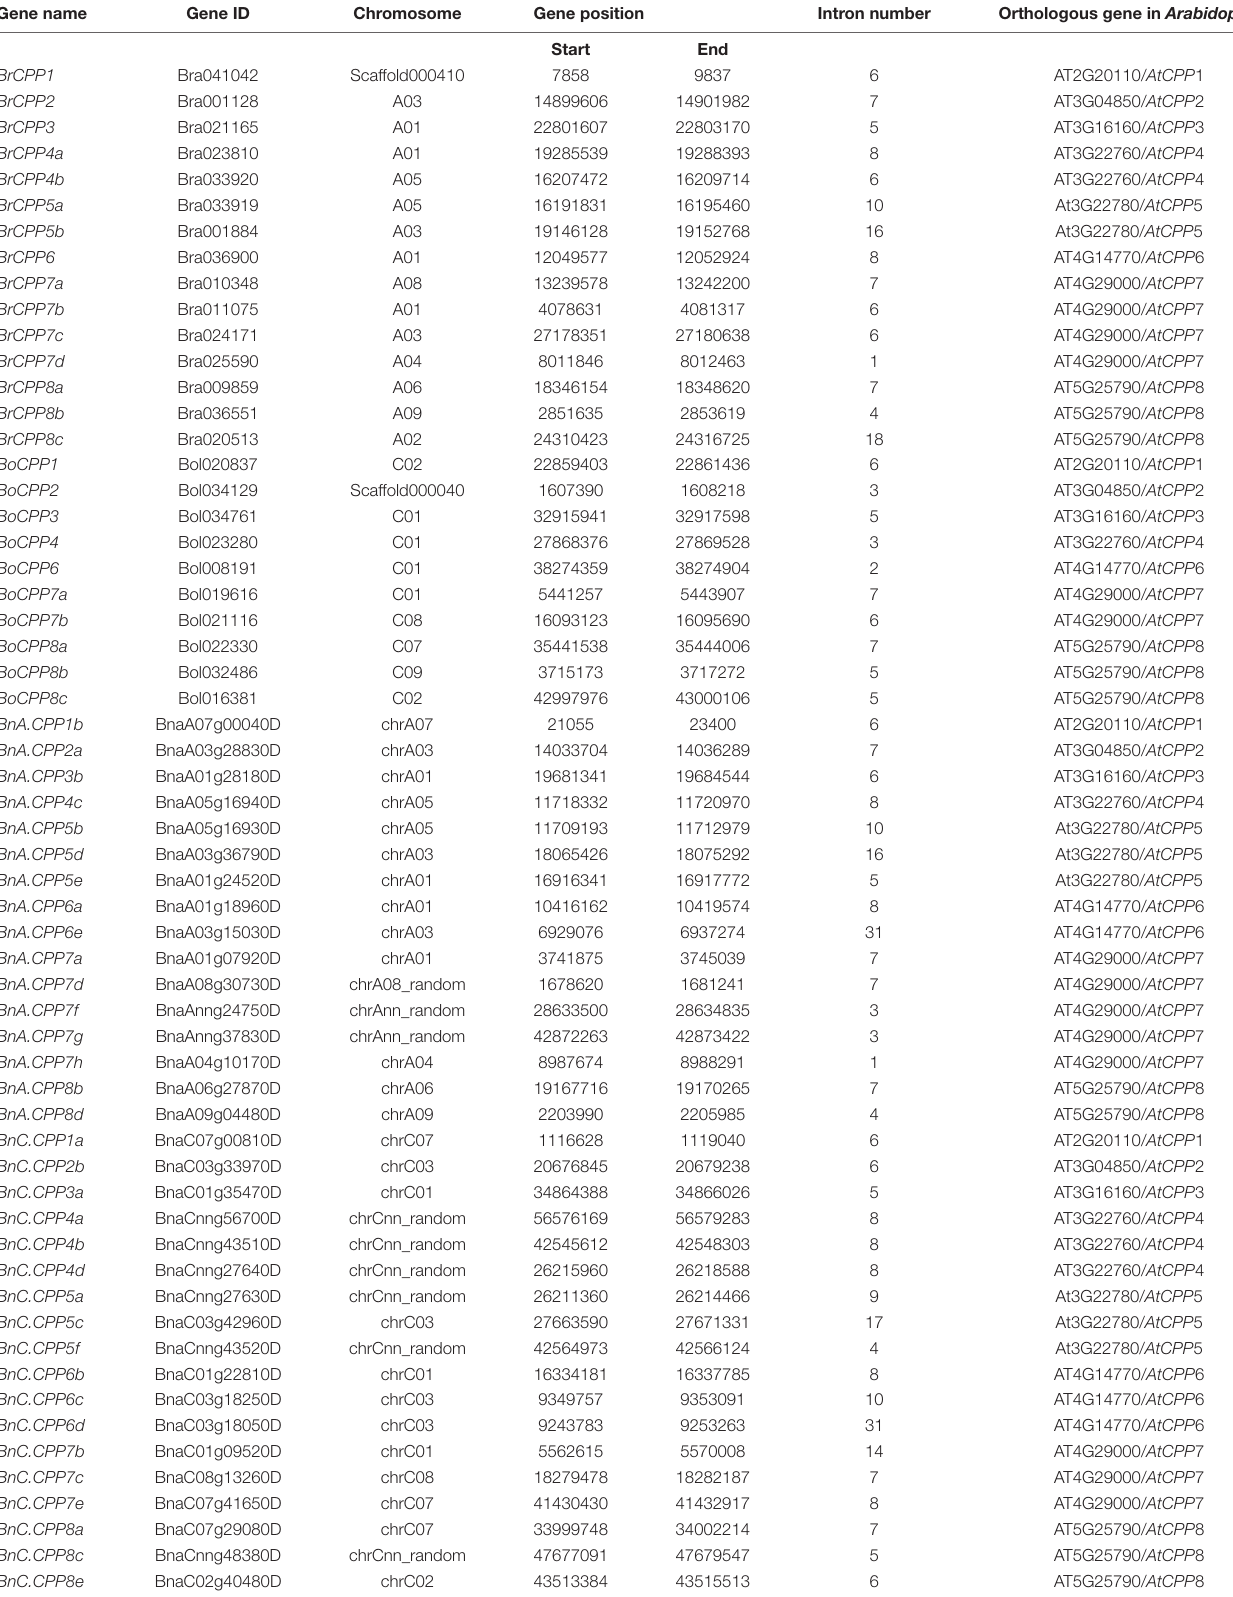
TABLE 1 | The CPP gene family information in B. napus and its diploid